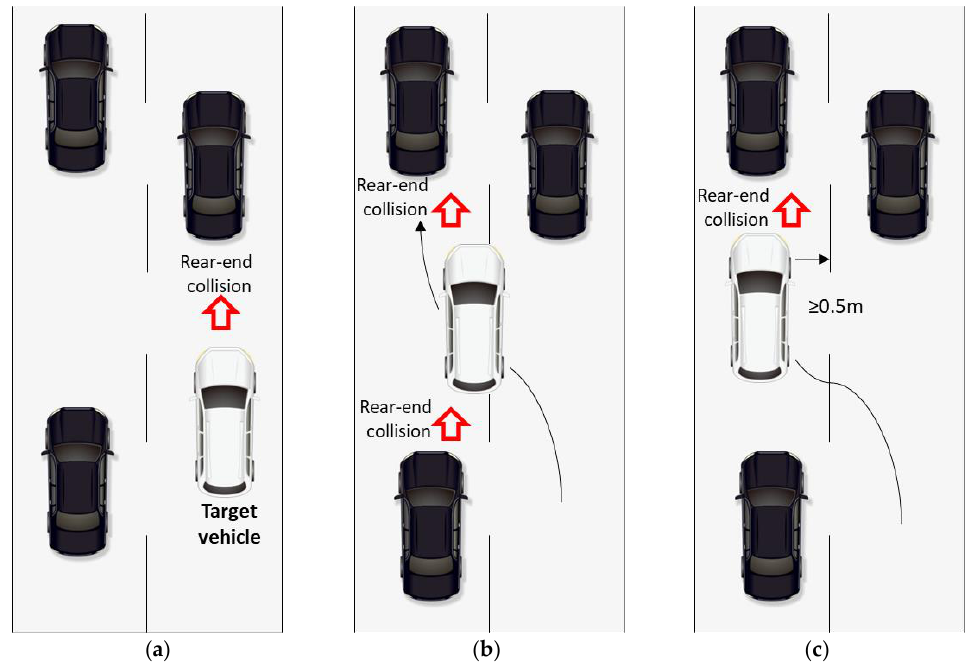
Figure 2. Rear-end collision evaluation for the target vehicle.